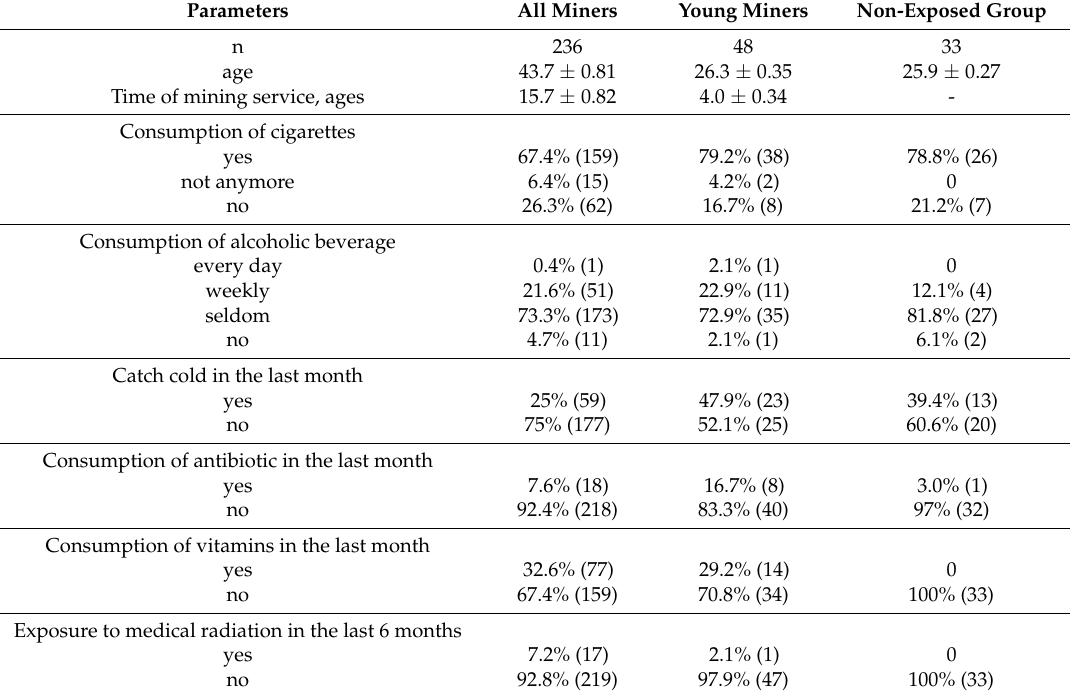
Table 1. Prevalence of sociodemographic characteristics of the exposed and non-exposed